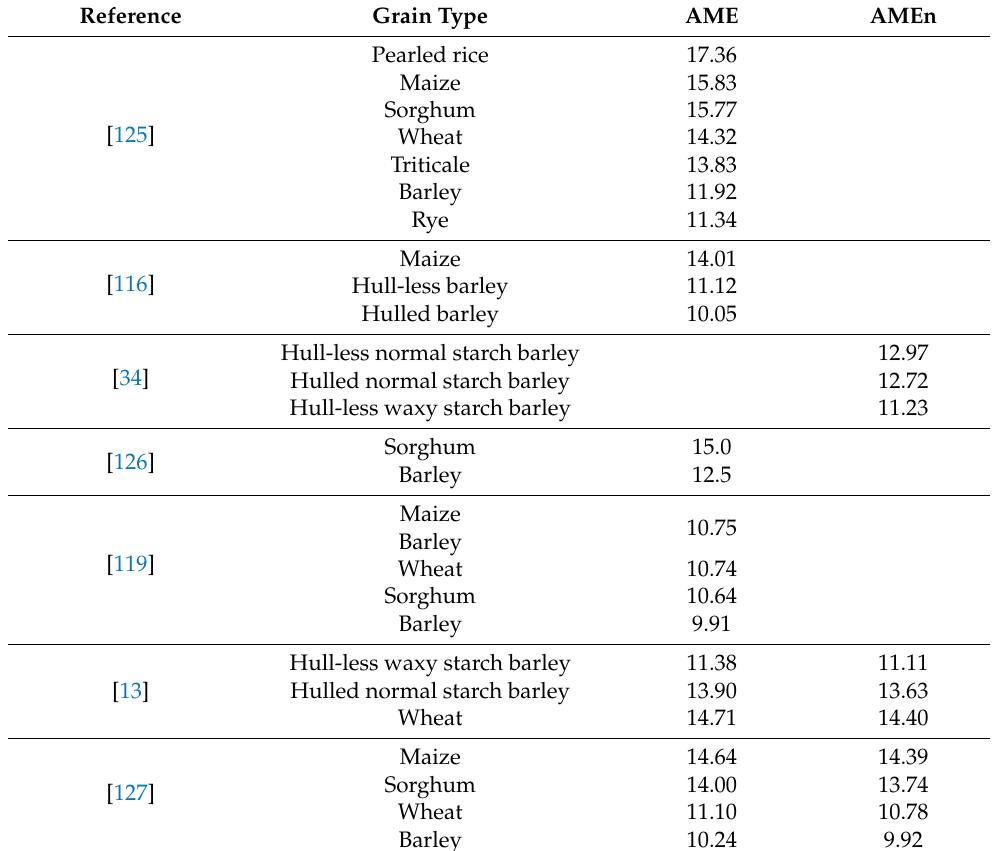
Table 6. Comparison of apparent metabolisable energy (AME; MJ/kg DM) and nitrogen-corrected AME (AMEn; MJ/kg DM) of different cereal grains for